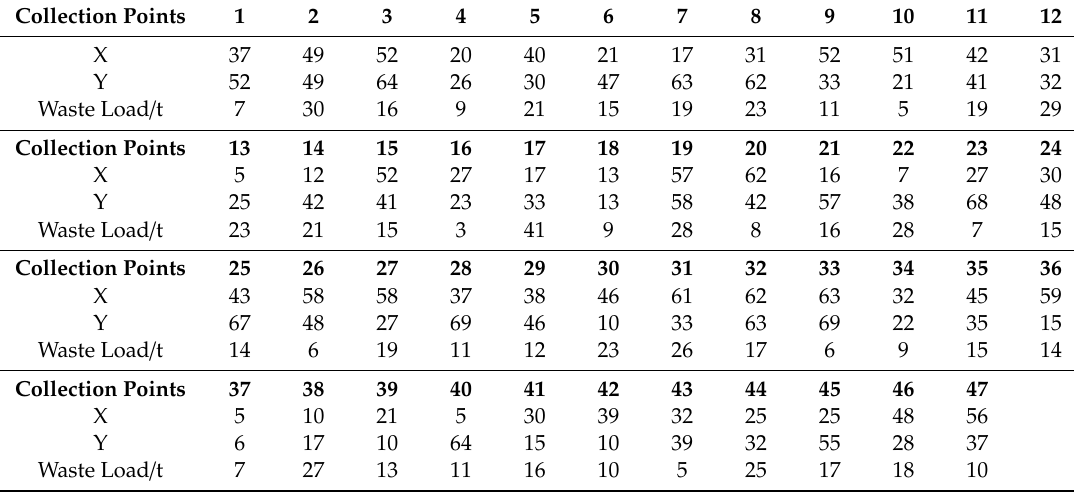
Table 9. Positions and waste load of collection points on